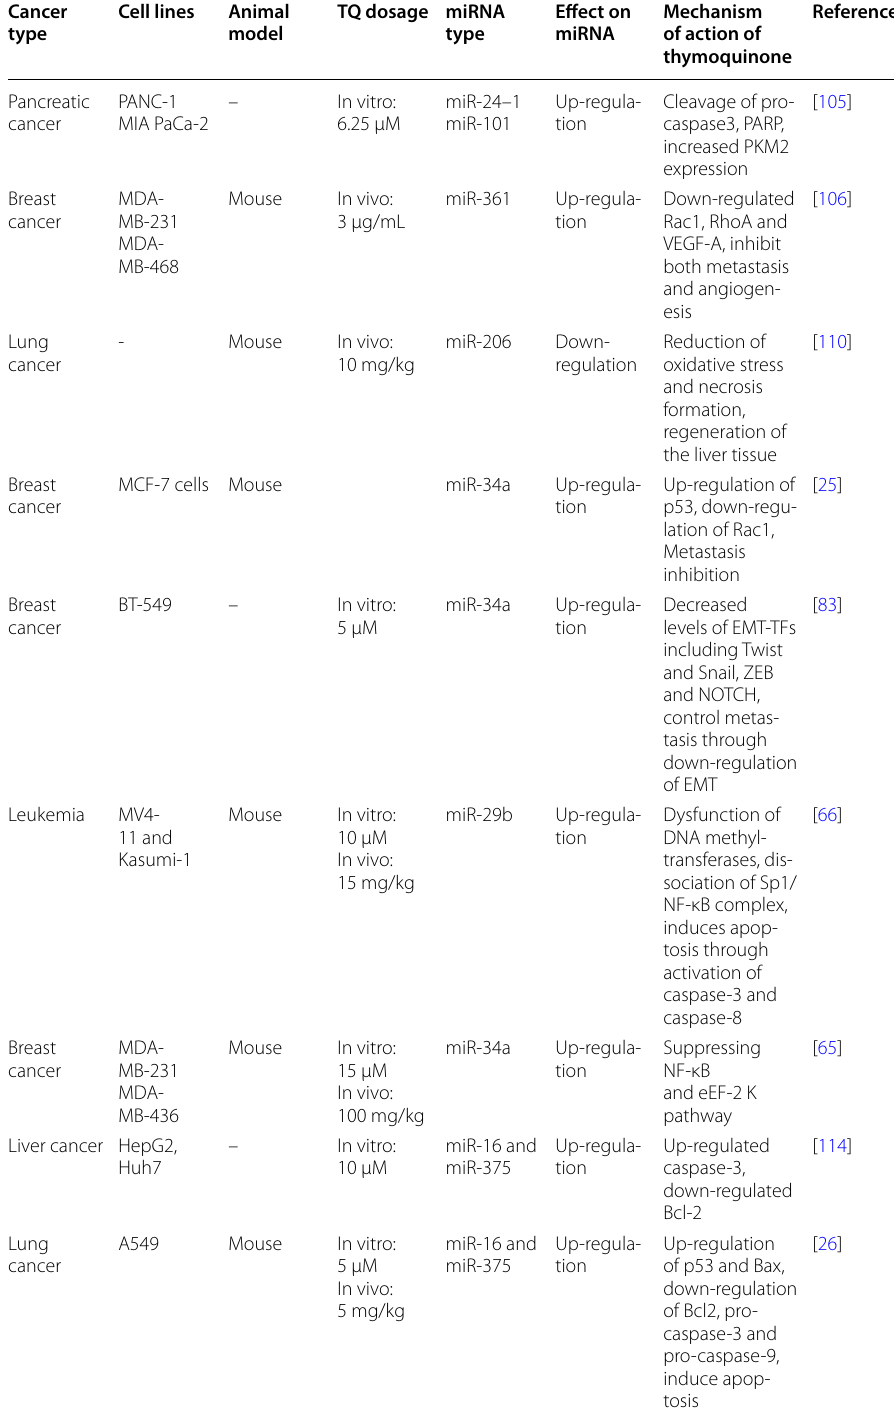
Table 1 Effect of thymoquinone (TQ) on the function of different miRNAs in the course of cancer